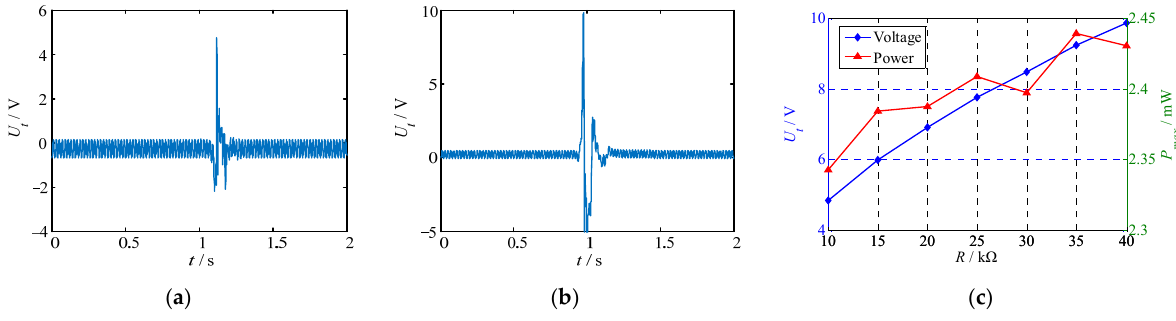
Figure 10. Instantaneous voltage and power of the proposed piezoelectric generator. ( a ) Instantaneous voltage at R = 10 K Ω ; ( b ) instantaneous voltage at R = 40 K Ω ; ( c ) instantaneous power.